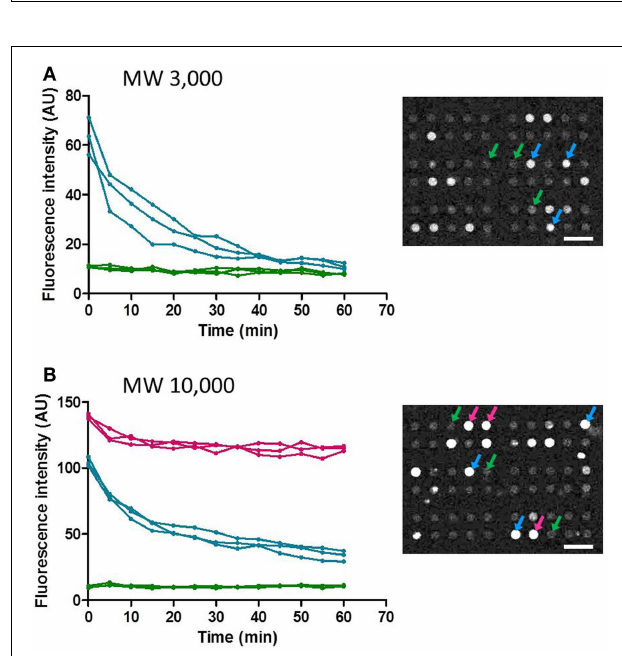
FIGURE 6 |Time-course of the fluorescence intensity retained in the selected microchamber . Data points obtained at every 5min were plotted for clarity. (A) MW 3,000. (B) MW 10,000. All scale bars in micrographs represent 50 µ